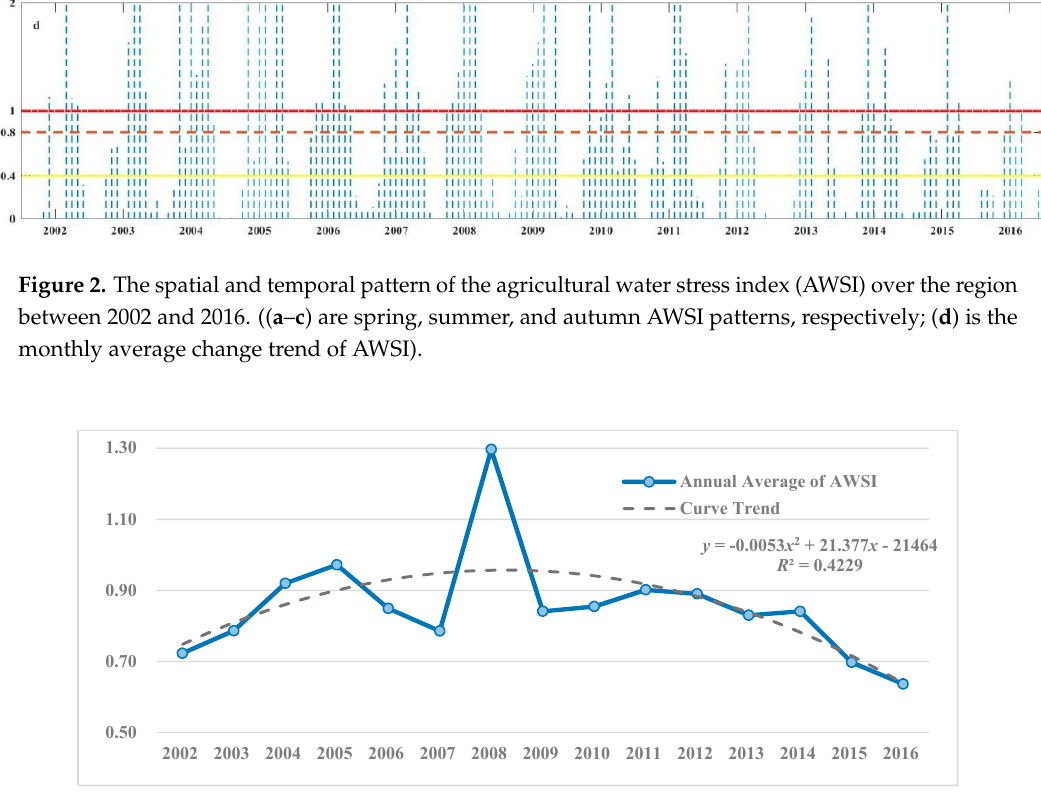
Figure 3. The annual average trend of AWSI and its quadratic fitting during 2002–2016.